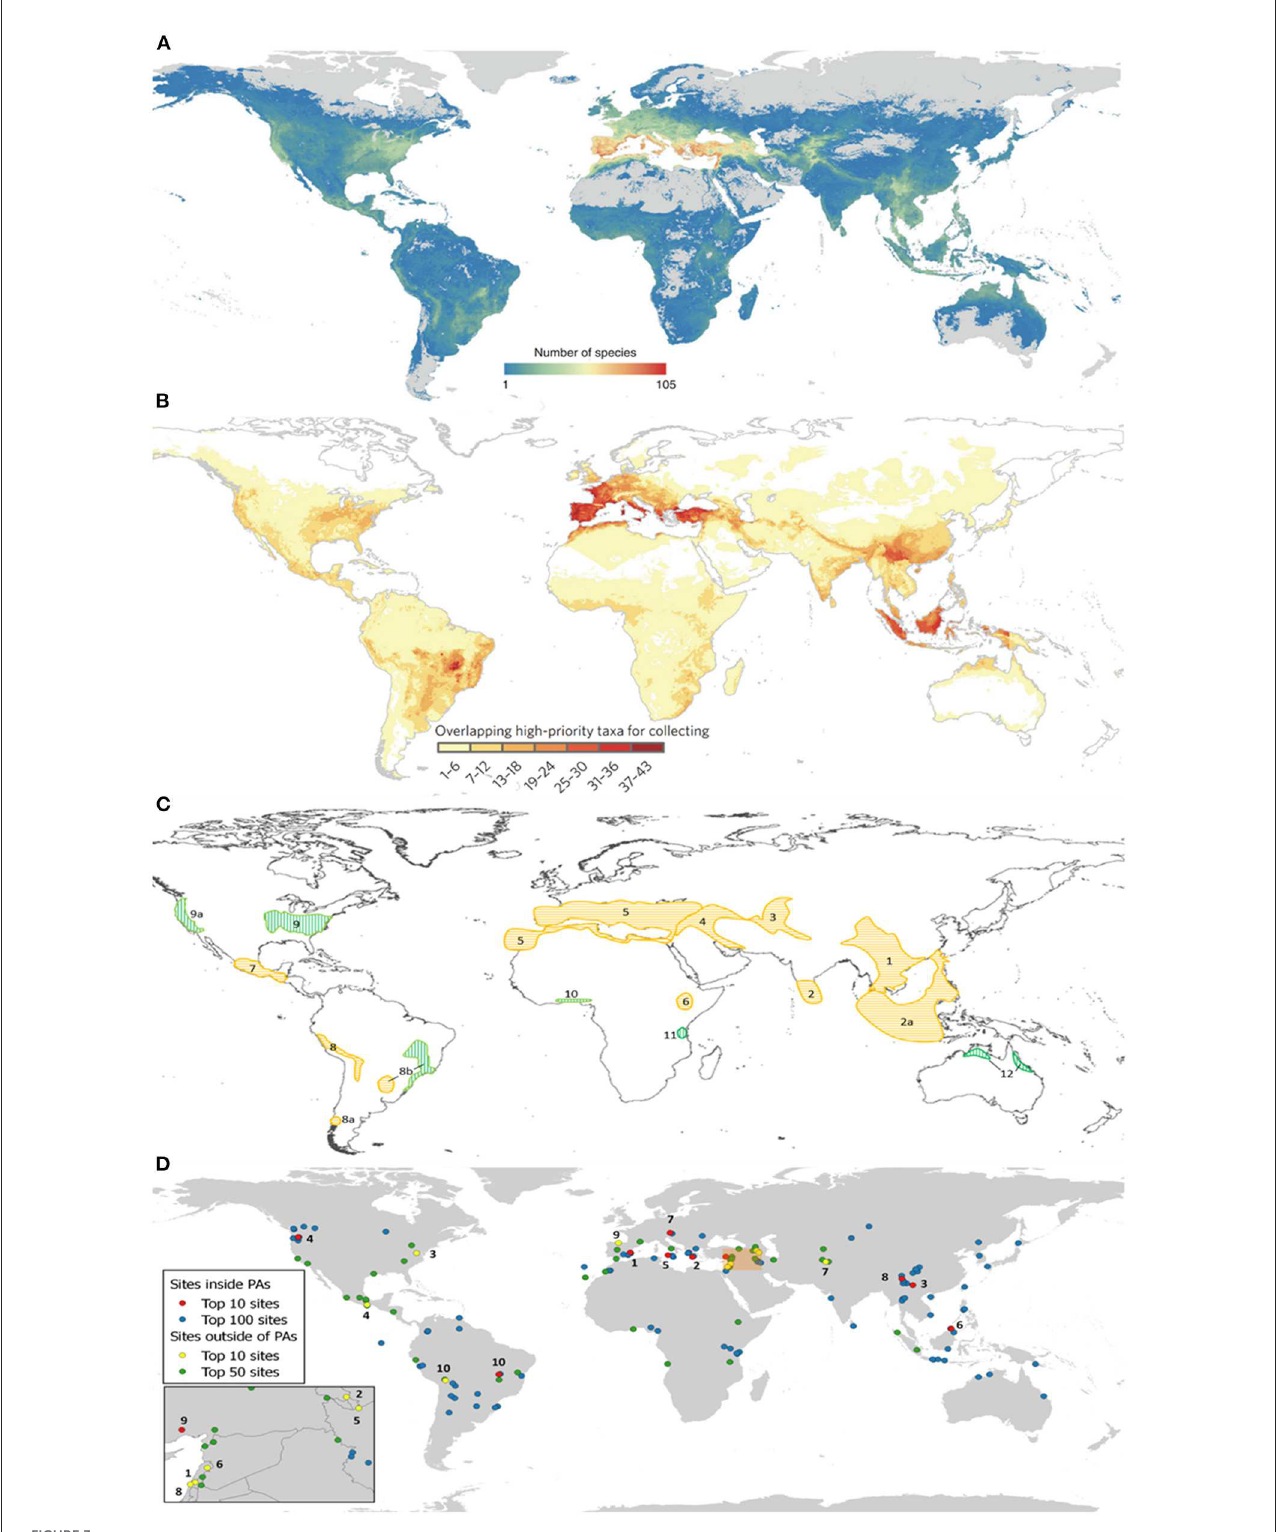
FIGURE3 (A) CWR richness for 1,261 CWR species related to 167 crops (Vincent et al., 2019); (B) hotspots for further CWR collection (Castañeda-Álvarez et al., 2016); (C) revised Vavilov centers of diversity (Vavilov, 1926; Maxted and Vincent, 2021); and (D) top 170 sites for global in situ CWR conservation (Vincent et al.,